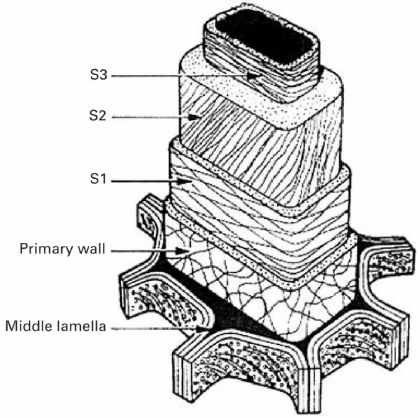
Figure 12. Schematic diagram of cellulose microfibrils in wood cell wall.